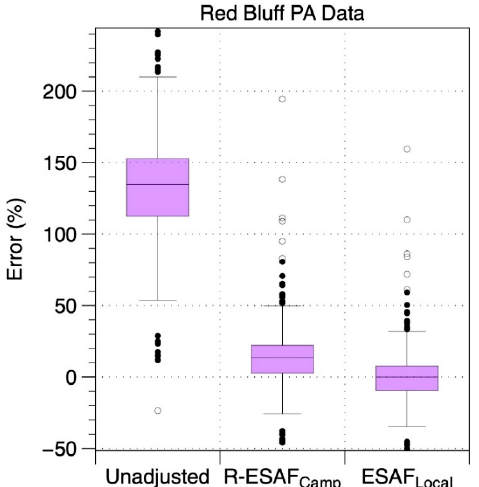
Figure 8. Distributions of errors for 4-h average PM 2.5 concentrations for Red Bluff PA-II direct readings and after applying the regional event specific adjustment factors from Camp Fire (R-ESAF) or those derived for the local Carr / Mendocino Complex